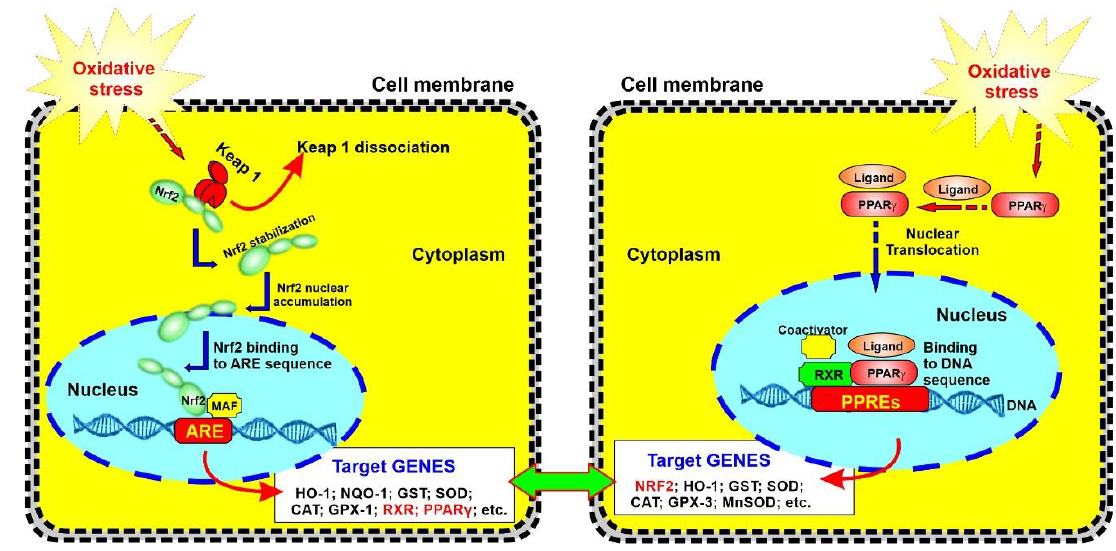
Figure 6. Schematic representation of crosstalk between Nrf2 and PPAR γ pathways in relation to OS and inflammation. Recent data by others suggests that Nrf2 and PPAR γ might reciprocally reinforce the expression of one another, thus synergistically boost the antioxidative response system.